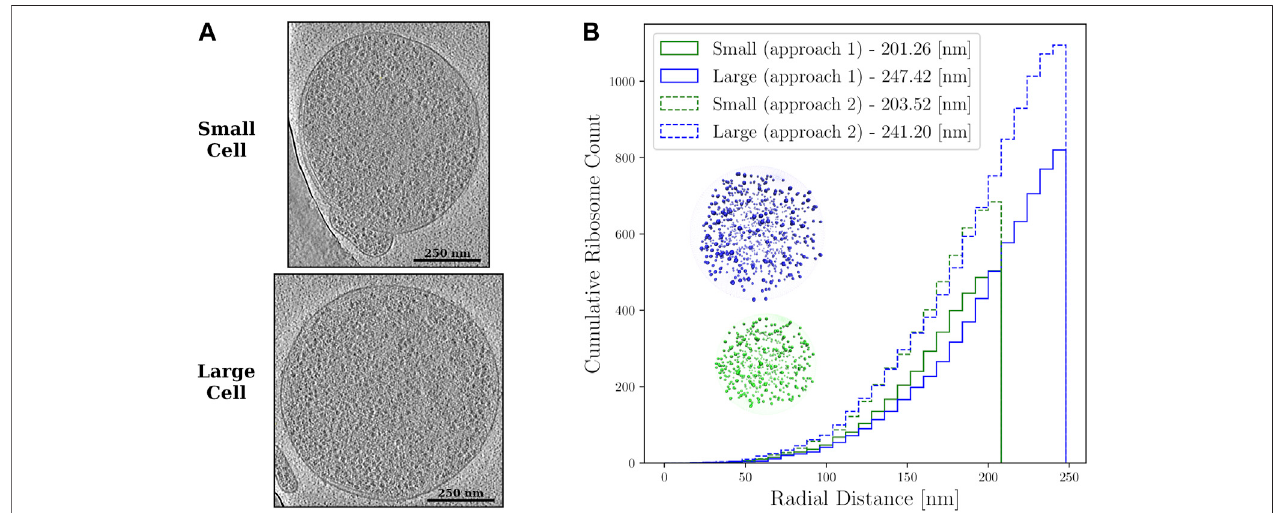
FIGURE 2 | (A) — Z-slices from the cryo-ET data of the small and large Syn3A cells. The ribosomes are the objects with higher density than the surrounding cytoplasm that are distributed throughout the cells. (B) — Cumulative ribosome distributions with 8 nm bins in the reconstructed spherical geometries of a small cell of radius 201.26 nm with 503 ribosomes and large cell of radius 247.42 nm with 820 ribosomes when the fi rst approach was used, and a small cell of radius 203.52 nm with 684 ribosomes and large cell of radius 241.20 nm with 1,095 ribosomes when the second approach was used. Also shown are the reconstructed spherical geometries resulting from the fi rst approach to template